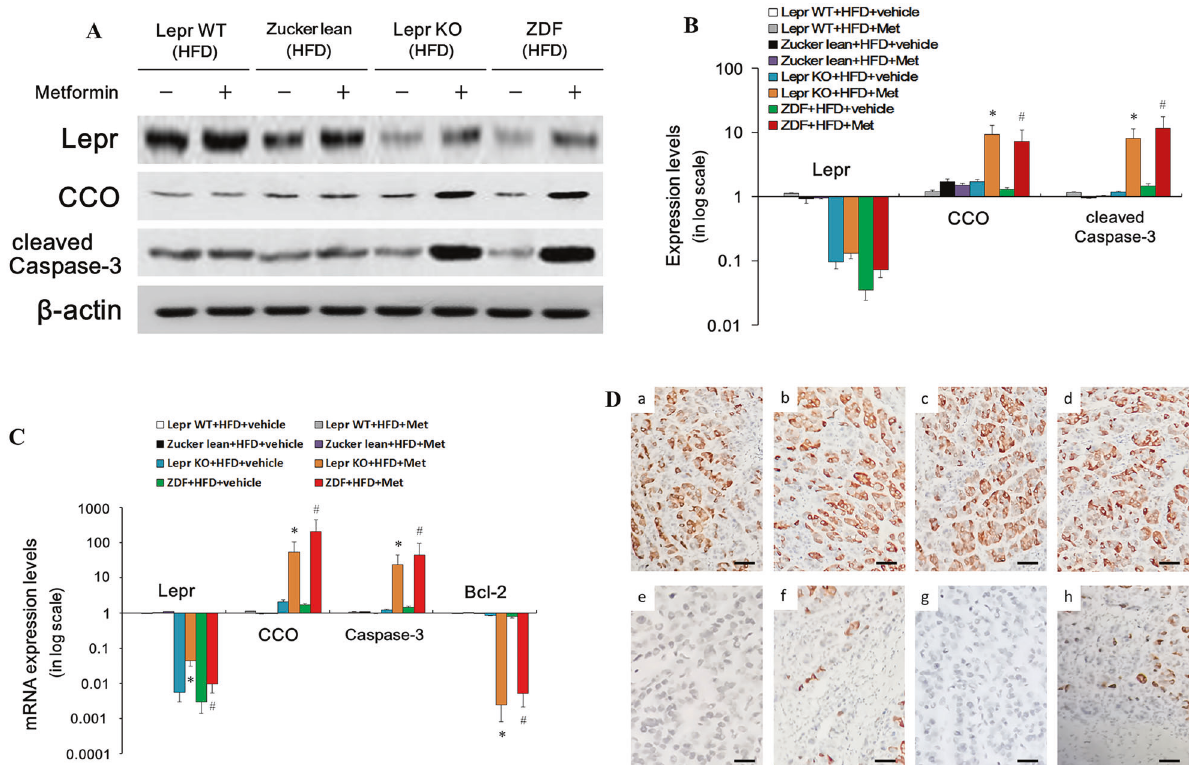
Fig. 4 Protein and mRNA levels of Lepr, cleaved Caspase-3, Bcl-2 and CCO in the livers of HFD-fed Lepr-WT, Zucker lean, Lepr-KO and ZDF rats, with and without metformin treatment. A Western blotting for proteins derived from freshly harvested liver tissue. B Quantitative analysis of A . n = 12. Band intensities in A were quanti fi ed in Image Lab (Bio-Rad) and the protein expression level was normalized to the β -actin level. Data are presented on a logarithmic scale as the fold change in expression relative to Zucker lean + HFD. C Quantitative real-time RT-PCR analysis for mRNA of the liver tissues (as indicated). n = 12. D Immunohistochemical analysis for Lepr. a Lepr WT + HFD + vehicle; b Lepr WT + HFD + Met; c Zucker lean + HFD + vehicle; d Zucker lean + HFD + Met; e Lepr-KO + HFD + vehicle;